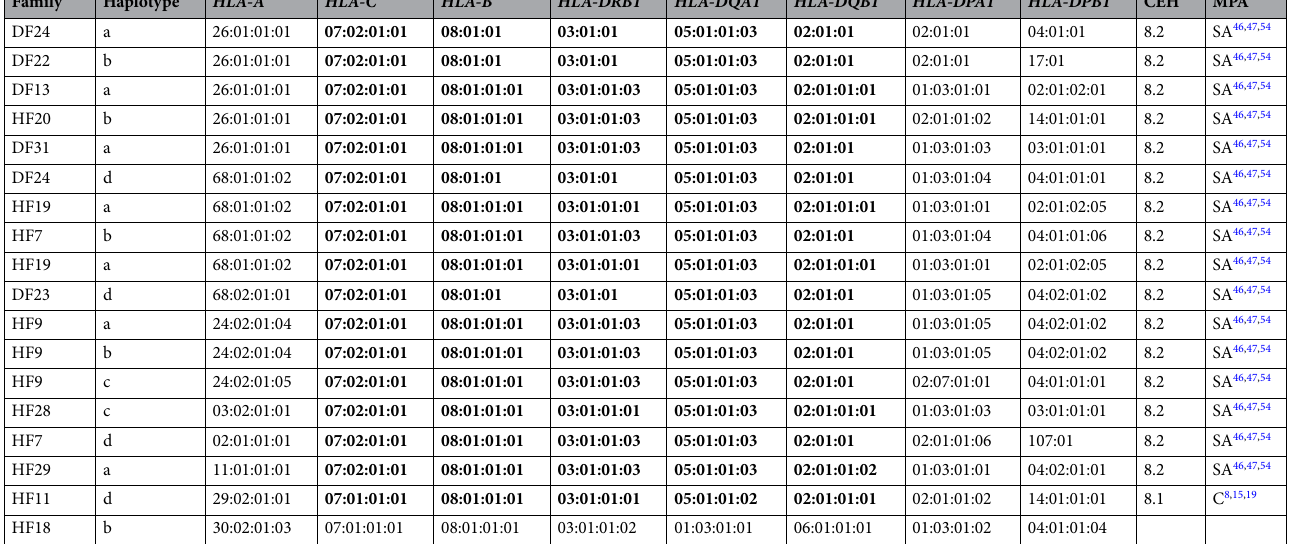
Table 7. MHC haplotypes of the UAE families selected on the basis of HLA-B*08:01 . The group of alleles that make up the designated CEH in column “CEH” are denoted in bold. CEH: conserved extended haplotypes; MPA: Most probable Ancestry; SA: South Asian; C: Caucasian.